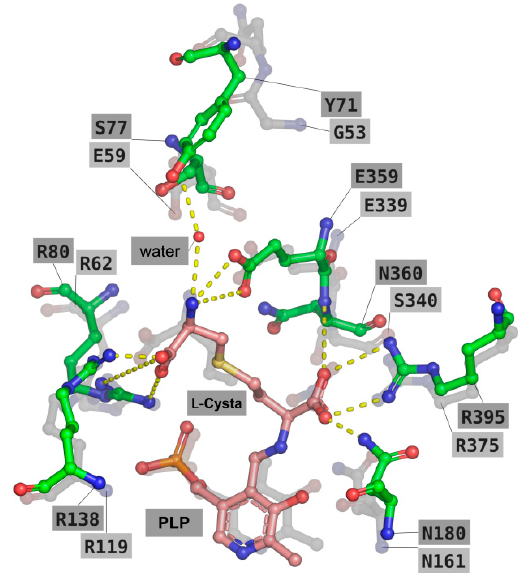
Figure 5. Modelling of the external aldimine of wild type TgCGL in complex with L -cth. TgCGL is shown as green sticks and is superposed to human CGL (PDB: 3COG; transparent gray sticks). The external aldimine is shown as pink sticks. Residues described in text are labeled in single-letter code. Potential favorable interactions are depicted as yellow. Other atoms are colored according to the following scheme: oxygen, red; nitrogen, blue; sulfur, yellow; phosphorus, orange.